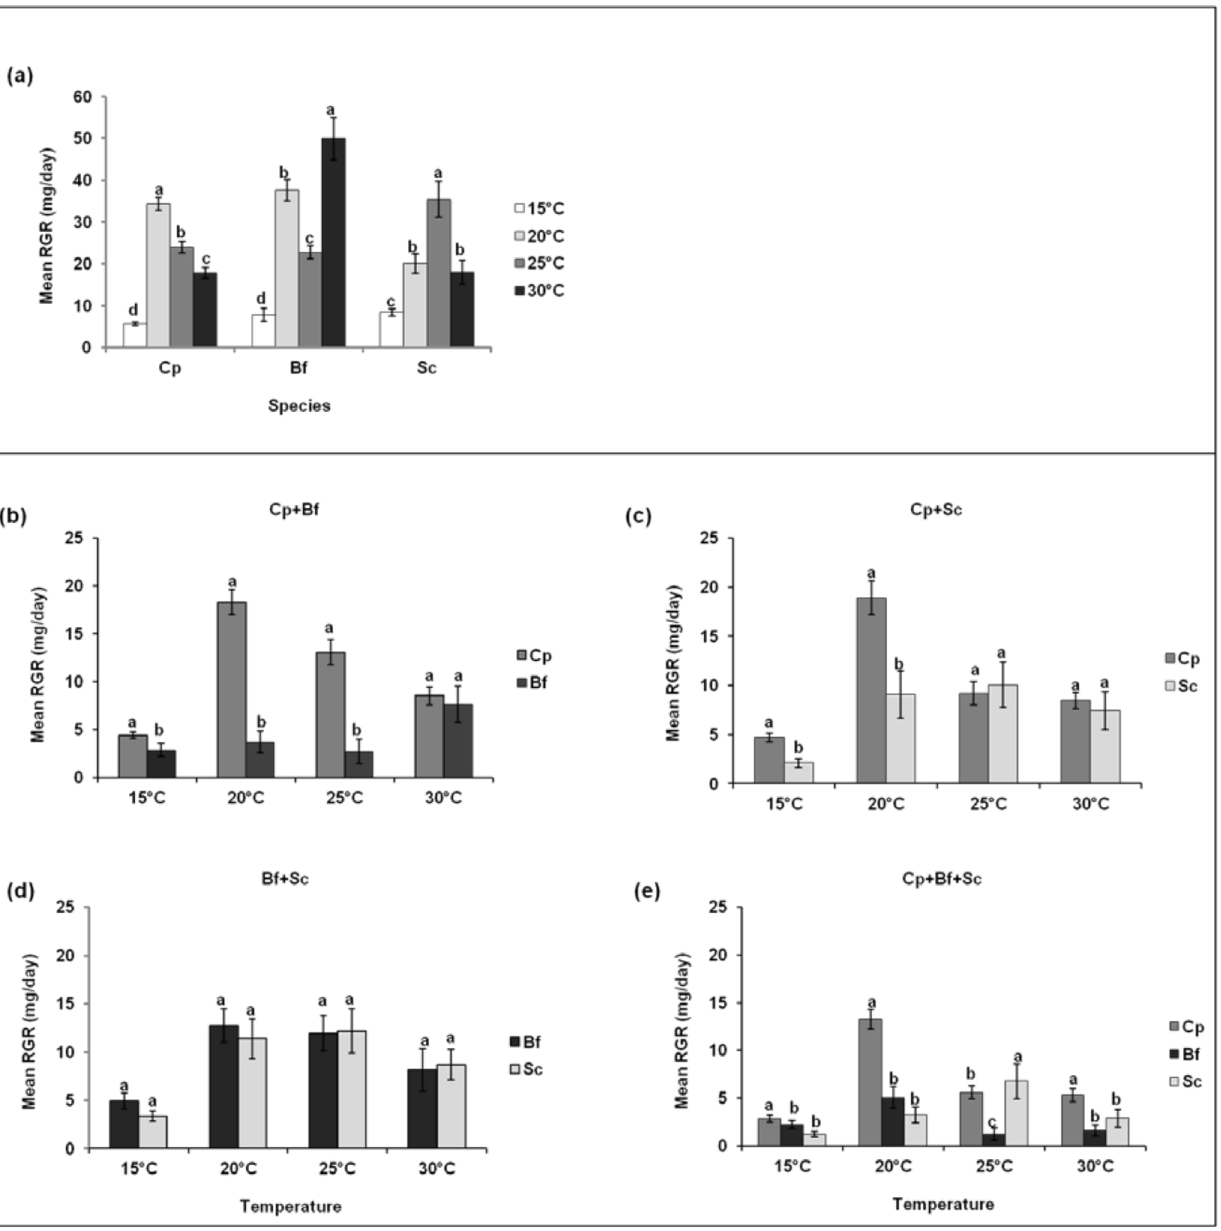
Fig 5. Comparison of the relative growth rates (RGR) of Chilo partellus (Cp), Busseola fusca (Bf) and Sesamia calamistis (Sc) larvae as single- species (a) and between borer species in multi-species communities at different constant temperatures (b-e) . Means ( ± SE) with different letters are significantly different at 5% level according to the Student-Newman-Keuls